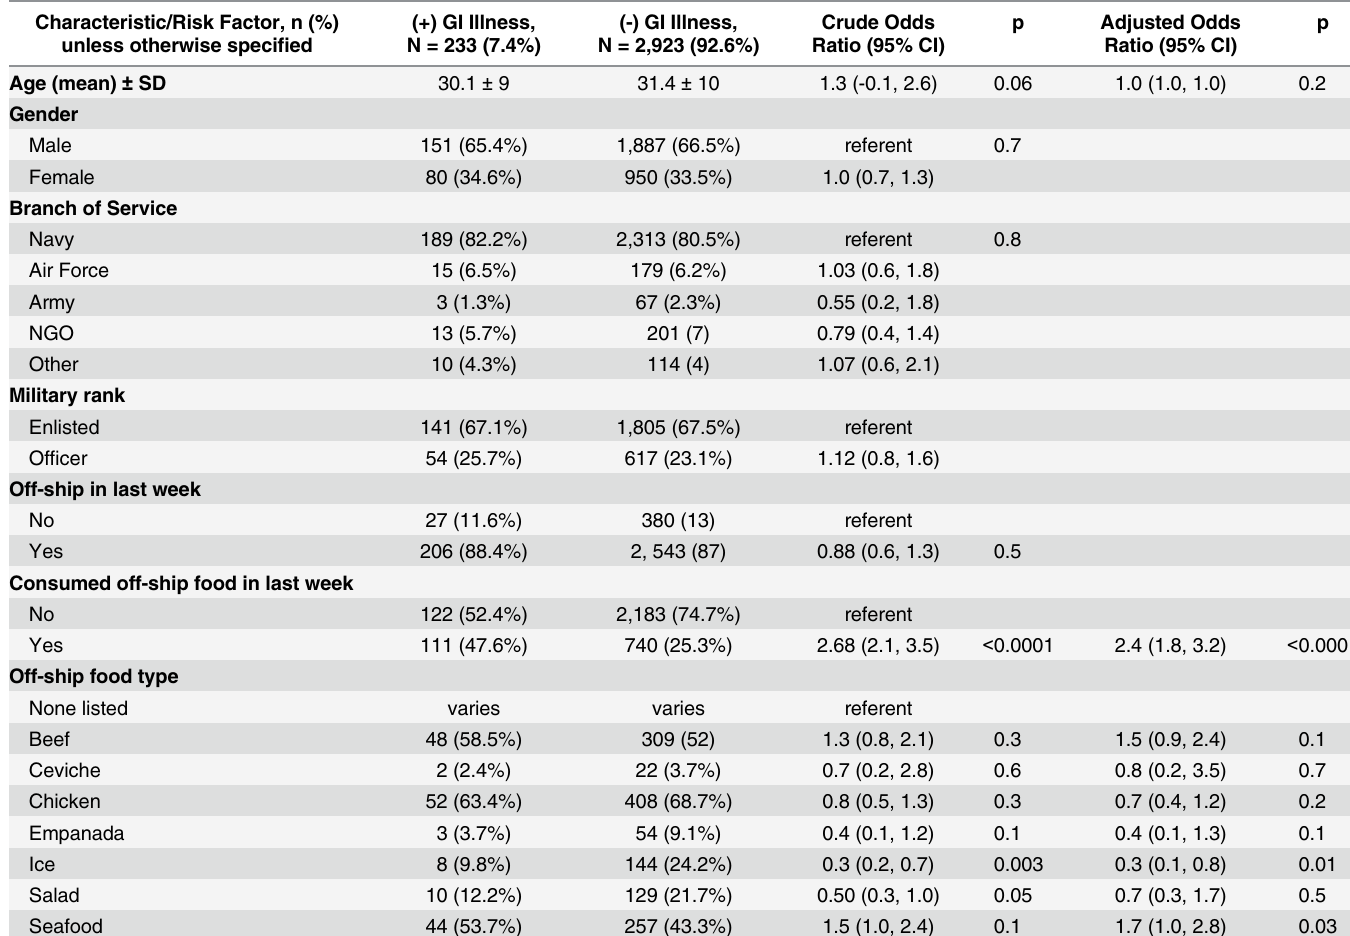
Table 2. Bivariate and Multivariate Analysis of Self-reported Travelers ’ Diarrhea from Active Surveillance (Weekly Questionnaire, N = 3,156). Characteristic/Risk Factor, n (%) unless otherwise speci fi